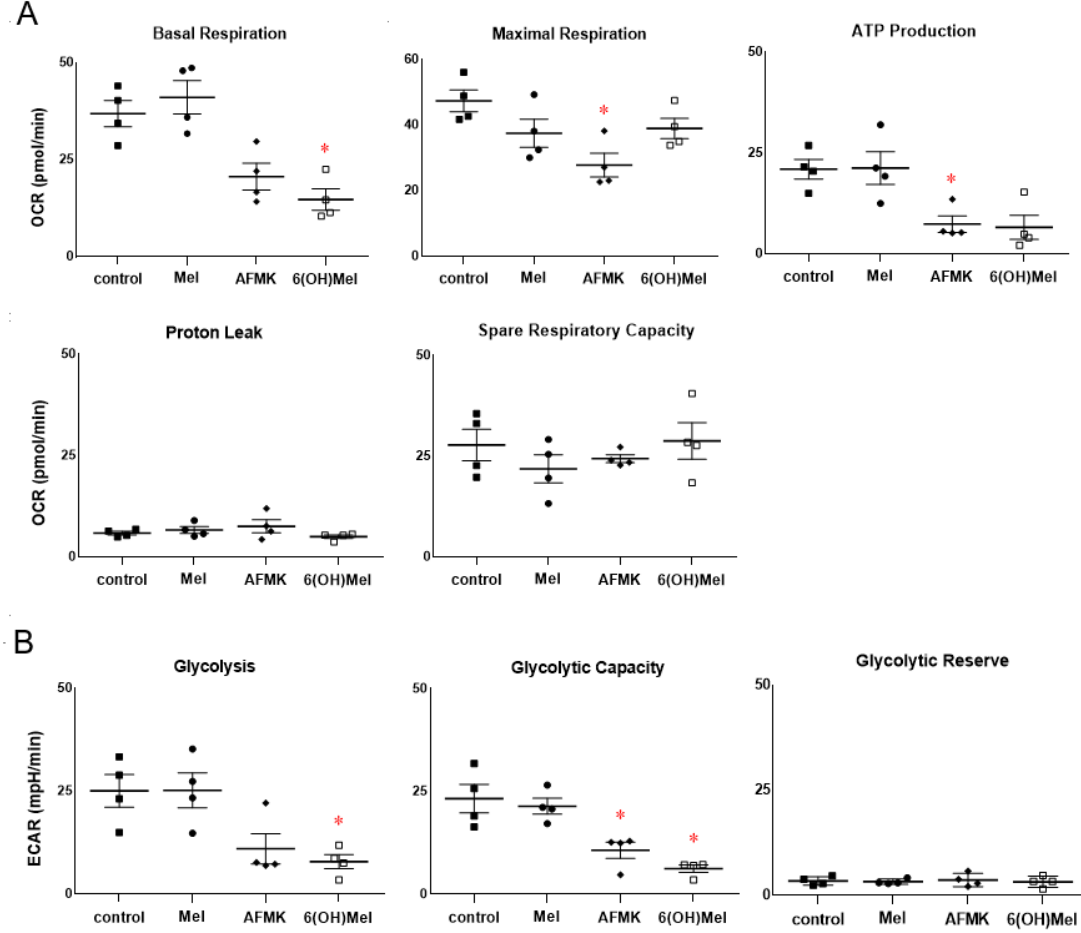
Figure 7. The Seahorse metabolic assay analysis performed in primary human epidermal keratinocytes treated with melatonin and its metabolites at a concentration of 10 − 5 M for 24 h. ( A ) : OCR and ( B ): ECAR parameters are presented along the procedure as described in Materials and Methods . The plots represent all values with calculated means and significance was evaluated both by Mann–Whitney U test and Student t -Test, which showed the same p values: * p < 0.05. Passages 2 and 3 of primary epidermal keratinocytes were used for the experiments.